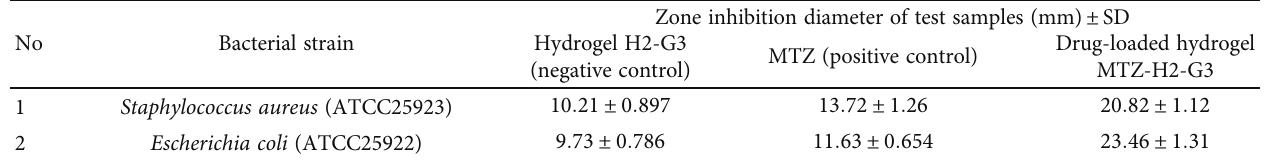
Table 4: Antibacterial activity of hydrogel